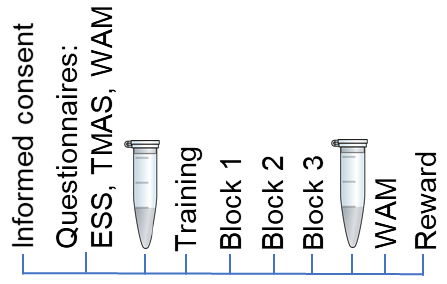
Figure 2. The schematic presentation of experimental steps; EES is the Epworth Sleepiness Scale; TMAS is Taylor’s Manifest Anxiety Scale; WAM is the ‘Wellbeing. Activity. Mood’ Questionnaire. The reward at the final stage of the test depended on the number of correct